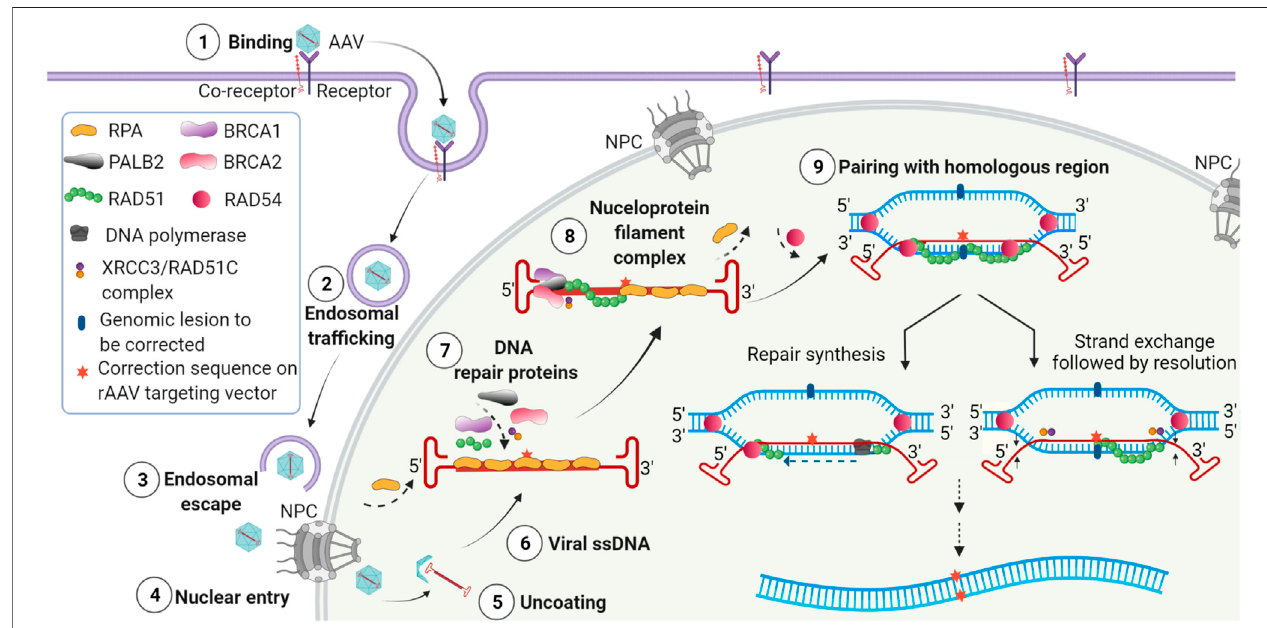
FIGURE 1 | Model of events following transduction by AAV editing vectors leading to genome editing. (1) Binding of AAV virions to cell surface receptor and co- receptors and initiation ofreceptor-mediated endocytosis. (2) Endosomalentry and traf fi cking ofthe AAV virions. (3) Release ofAAVs fromendosomes. (4) EntryofAAV throughthenuclearpore complex(NPC). (5) UncoatingofAAVvirions and release ofthesingle-stranded vectorgenomeinthe nucleus. (6) Thereleased singlestranded AAV vector genome with homology region and ITRs. (7) Recruitment of DNA repair proteins to the AAV editing genome containing the correction sequence. (8) Assembly of the HR complex on the AAV editing genome and formation of nucleoprotein fi lament complex. (9) Homology search between editing vector genome and chromosomal DNA leading to the pairing of homologous sequences and initiation of editing by repair synthesis (left) or strand exchange (right).